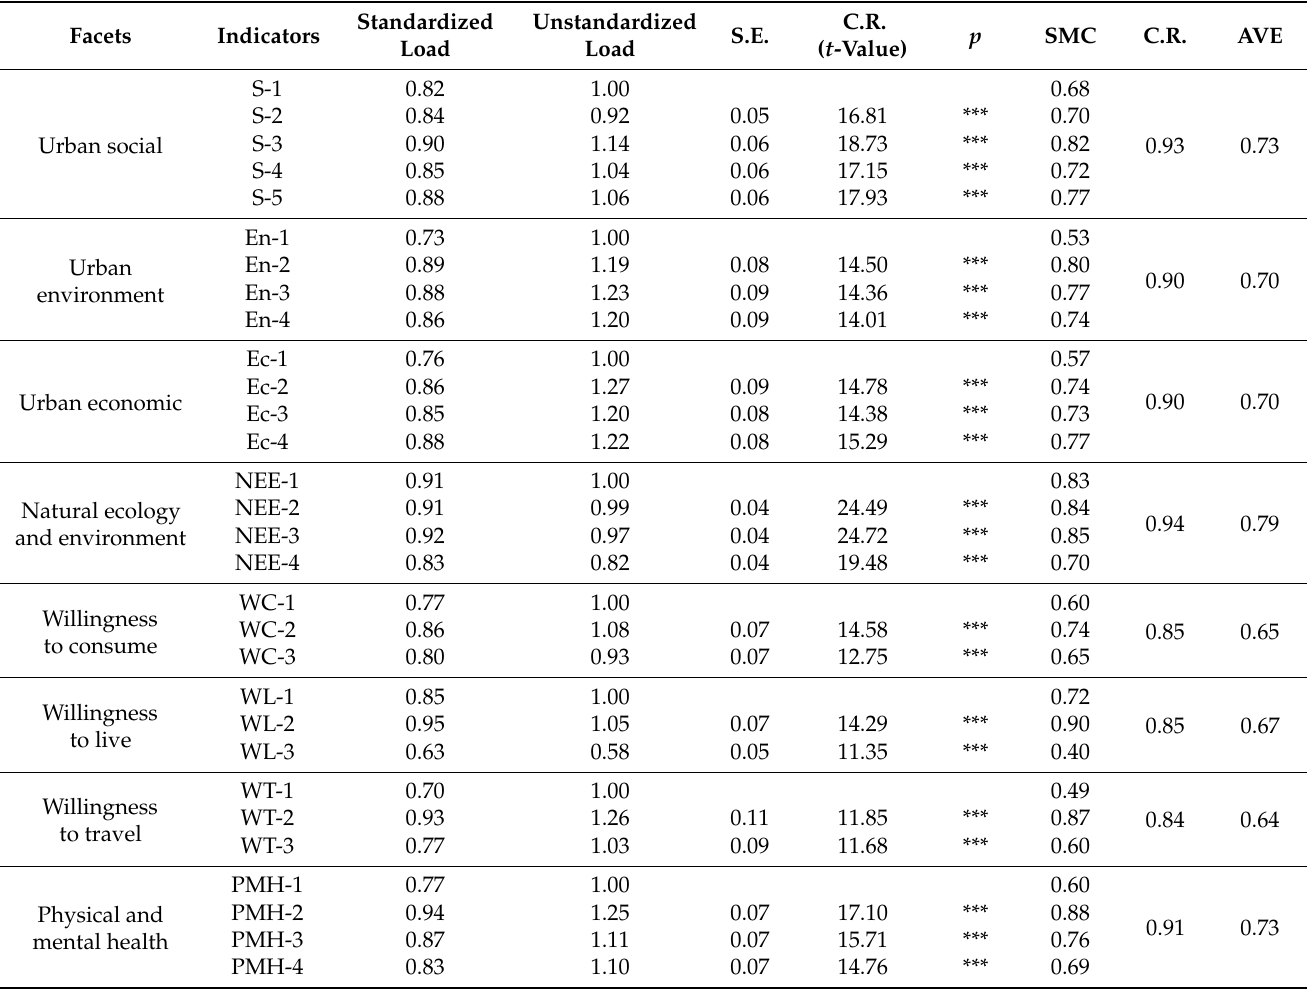
Table 2. Confirmatory factor